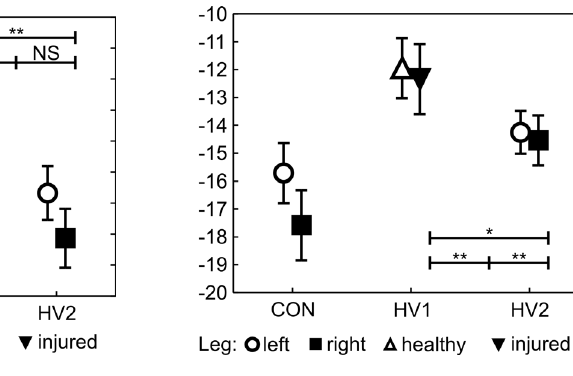
Fig.8 Peak hip extension (in deg) at terminal stance phase